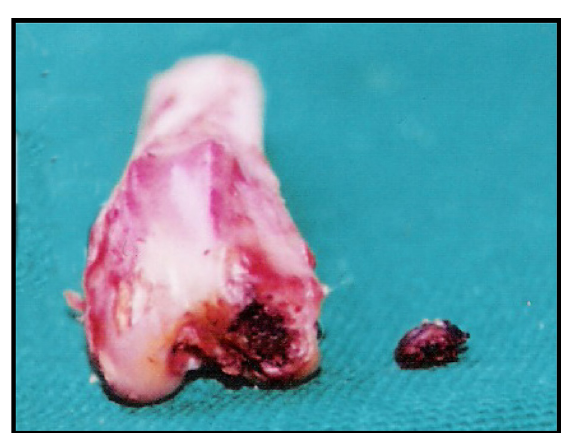
FIGURE 6 - Resorcina sticker with fixation flaw, presenting (cid:192) = bed empty osteocondra (cid:208) = free body.